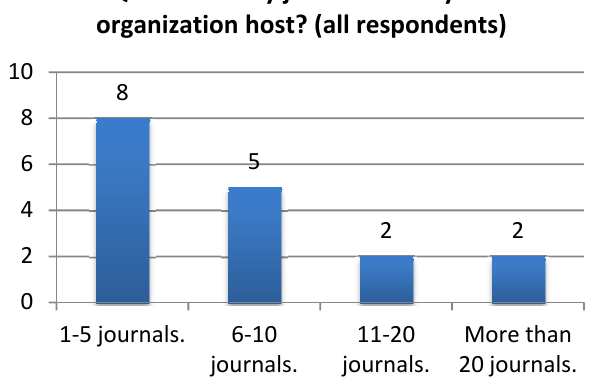
Figure 4. Number of OA journals